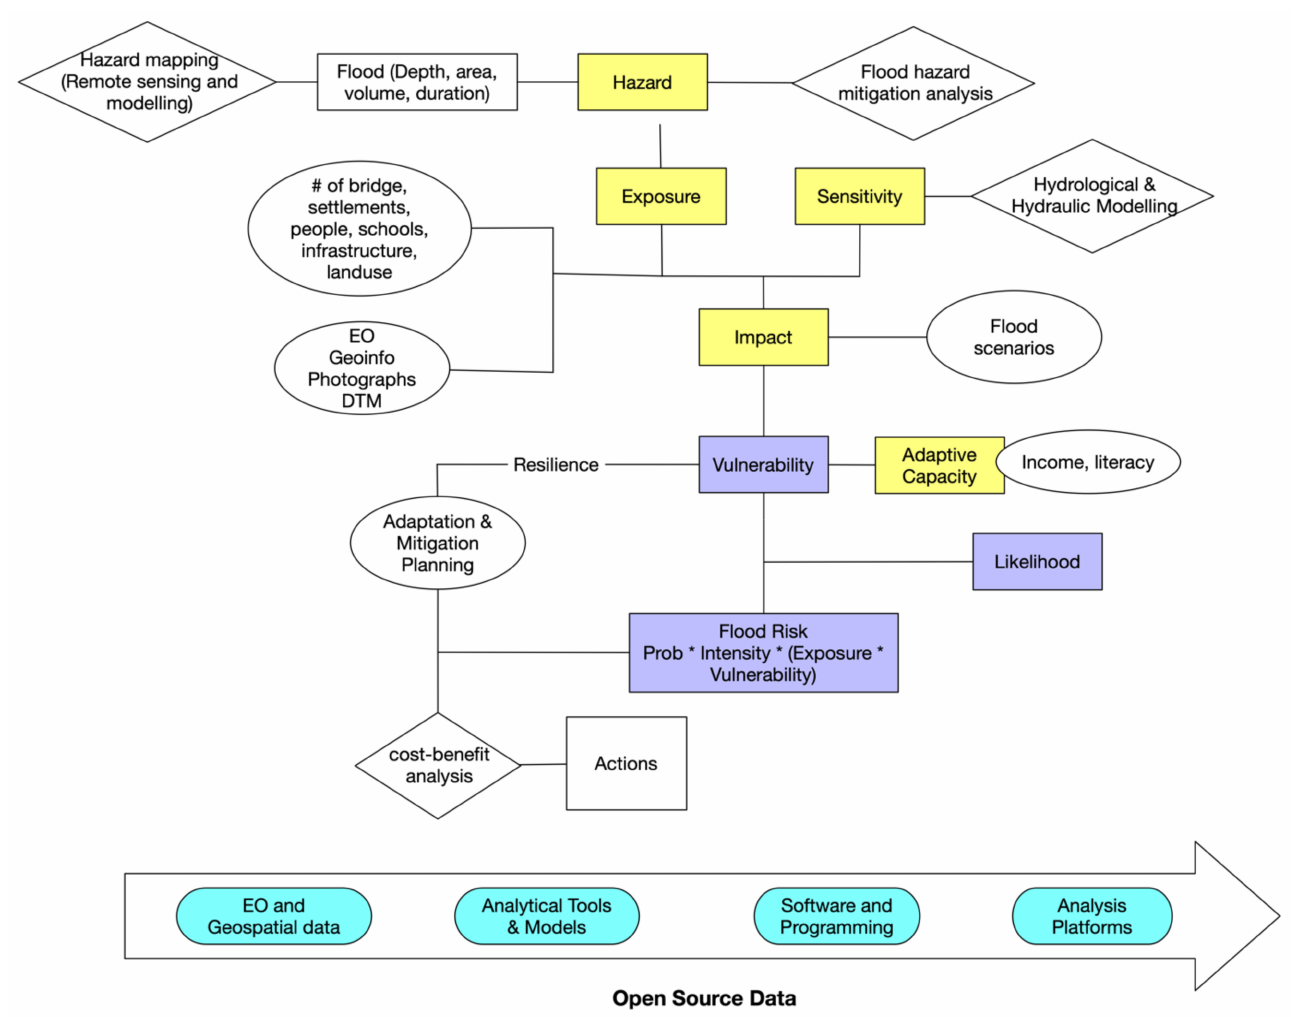
Figure 1. Flood risk assessment methods and conceptual framework of the study. Table 1. Details of the key words and articles screened for the analysis. Keywords/Search Strings